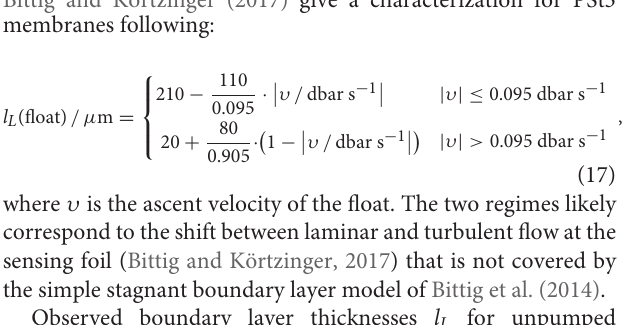
(normalized partial pressure 8 ( x ≥ l M + l L , t = 0 + ) = 1)